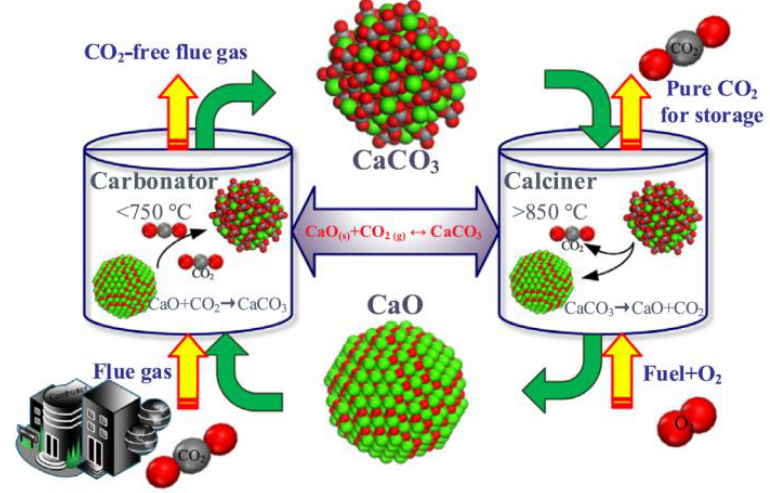
Figure 2. Schematic diagram of the calcium looping CO 2 capture process [14].